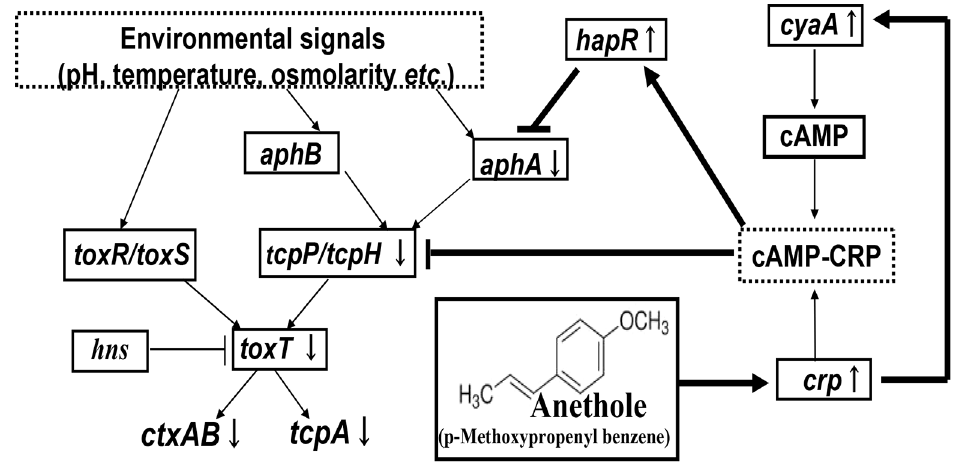
Fig 7. The hypothetical regulatory cascade of CT production inhibition in V . cholerae by anethole. In all cases, arrows indicate positive regulation while bars denote negative or inhibitory effects. Arrows besides the genes name represent significant increase and decrease of transcription of specific gene, in presence of anethole. Thick arrows represent the anethole-mediated effect on tcpPH suppression.